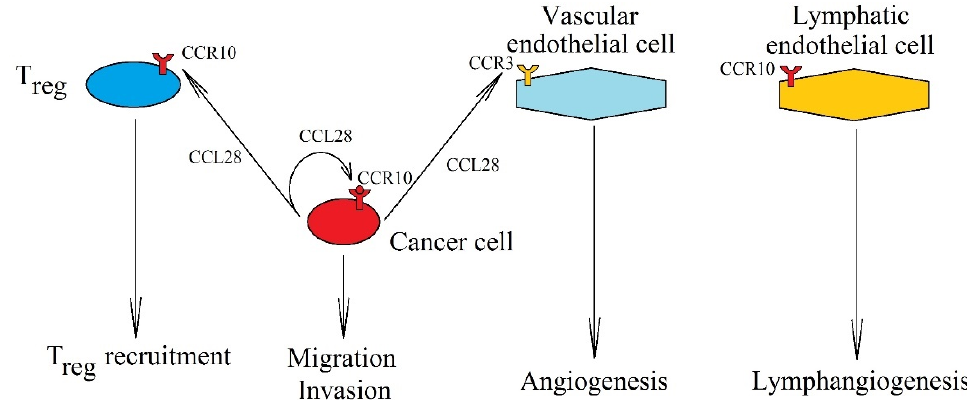
Figure 7. Significance of CCL28 expression increase in cancer processes. Expression of CCL28 in a cancer cell causes the migration and invasion of cancer cells via CCR10. CCL28 is also involved in T reg recruitment into the tumor niche by interacting with receptor CCR10 on these cells. It also causes vascularization of the tumor, causing angiogenesis by activating CCR3 on endothelial cells and lymphangiogenesis by activating CCR10 on lymphatic endothelial cells.